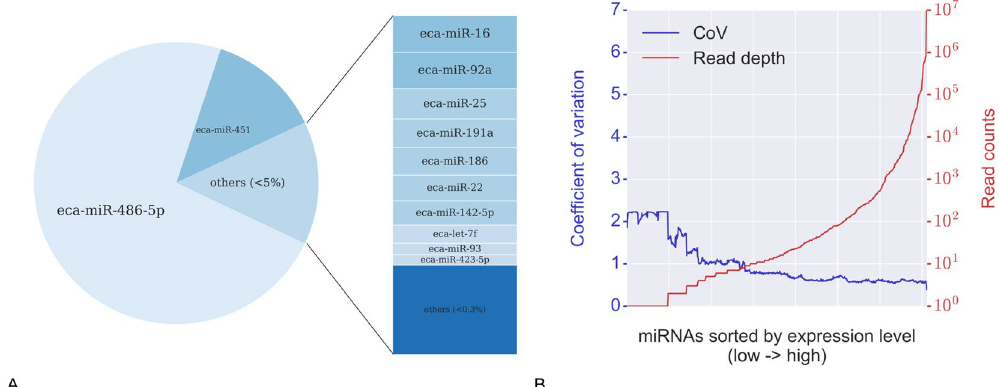
Figure 2. ( A ) The relative composition of miRNAs detected in infected and uninfected horse blood samples. Approximately 73% of all miRNA reads across the six samples corresponded to miR-486-5p, which is highly expressed in erythrocytes. miRNAS representing between 0.3–5% of total reads are drawn as a stacked bar to the right of the pie. The remaining miRNAs (“others < 0.3%”) each took up less than 0.3% of the total read pool, corresponding to a cutoff point of about 125,000 actual reads. ( B ) Inter-sample variance (blue line) decreases with increasing depth of sequencing (red line). MiRNAs with < 10 counts across the six samples had on average very high inter-sample